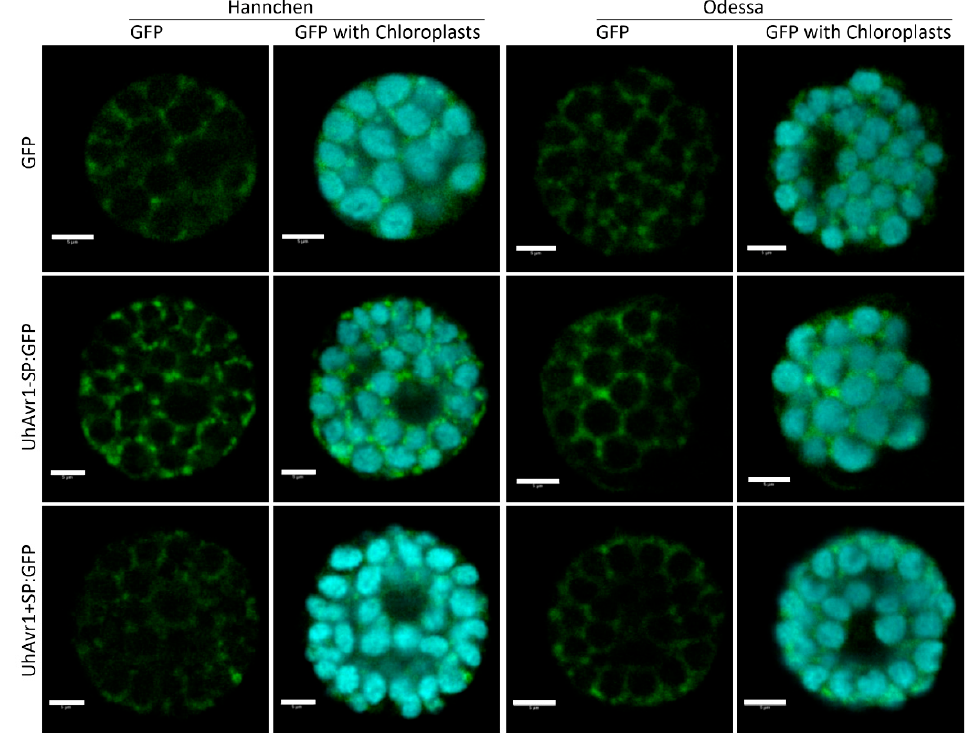
Figure 7. UhAVR1 localizes to the cytosol of barley protoplasts. Confocal imaging of protoplasts of cv. Odessa and cv. Hannchen 20 h post-transfection with 35S:GFP, 35S:UhAvr1-SP:GFP and 35S:UhAvr1 + SP:GFP. GFP fluorescence for all transiently expressed constructs in both cultivars localized to the cytosol surrounding chloroplasts and occasionally in cytosolic foci. Three experimental repeats were performed for cv. Odessa and two for cv. Hannchen with similar results. Scale bar for confocal images represents 5 µ m. A snapshot of a single optical section is displayed for all images.